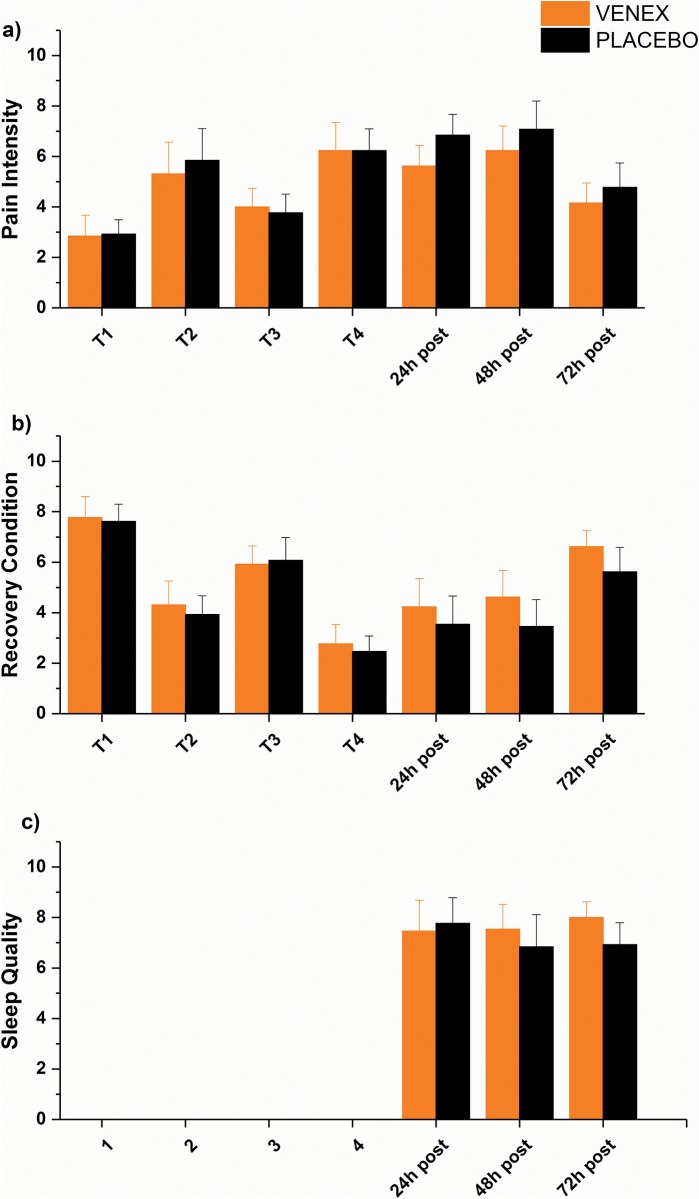
Mean ± 95% confidence interval of a) pain intensity (PI), b) recovery condition (RC) and c) sleep quality (SQ).There were no differences between treatments but a strong Cohen’s d of 0.8 for PI (a) 24h post and a medium Cohen’s d for RC (b) 24h post (0.6) and 48h post (0.7). Sleep quality (c) indicated a trend to significance with p = 0.068 during the third night and also a high Cohen’s d of 0.8 at this measurement.